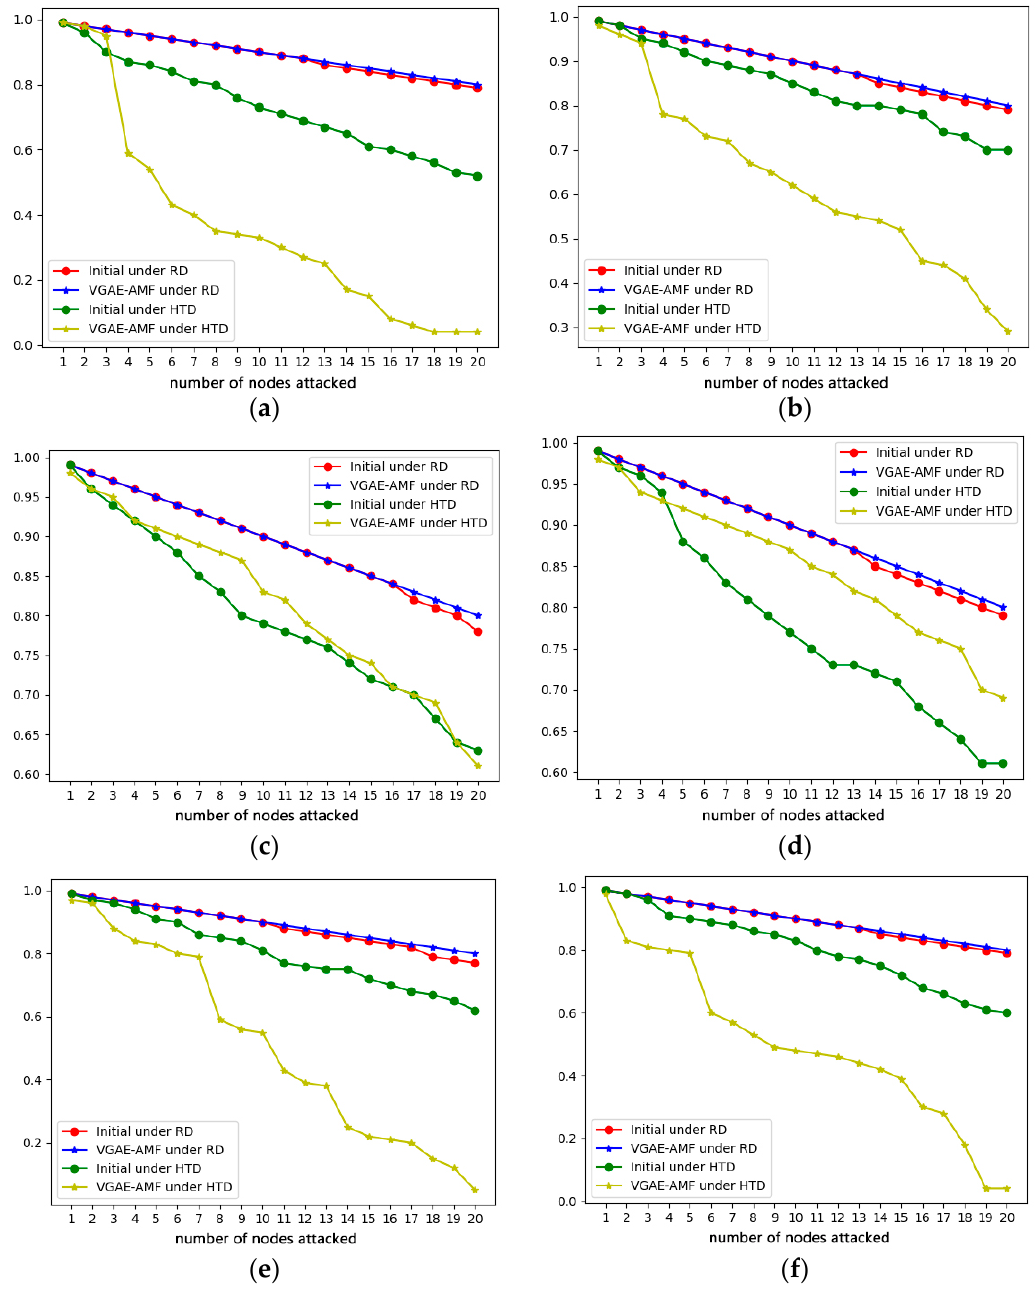
Figure 8. Effect of different values α on algorithm optimization: ( a ) α = 0.2; ( b ) α = 0.3; ( c ) α = 0.5; ( d ) α = 0.6; ( e ) α = 0.7; ( f ) α =